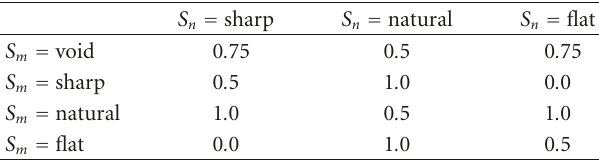
Table 3: Syntactic compatibility coe ffi cient between two accidentals in a bar, with no accidental of the same height in the key